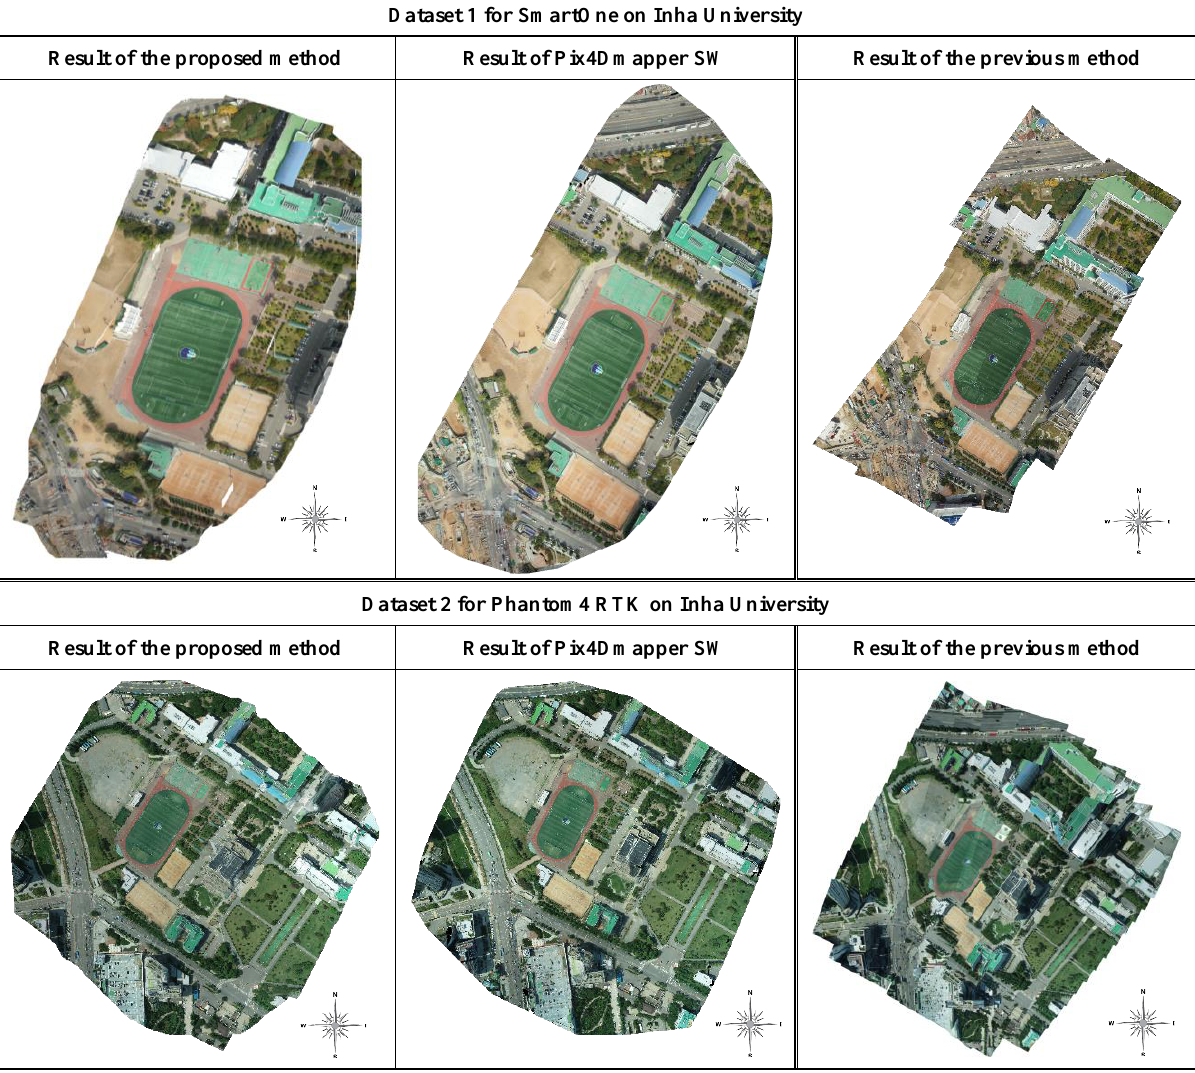
Table 7. Mosaic image of the proposed method, Pix4Dmapper SW, and the previous